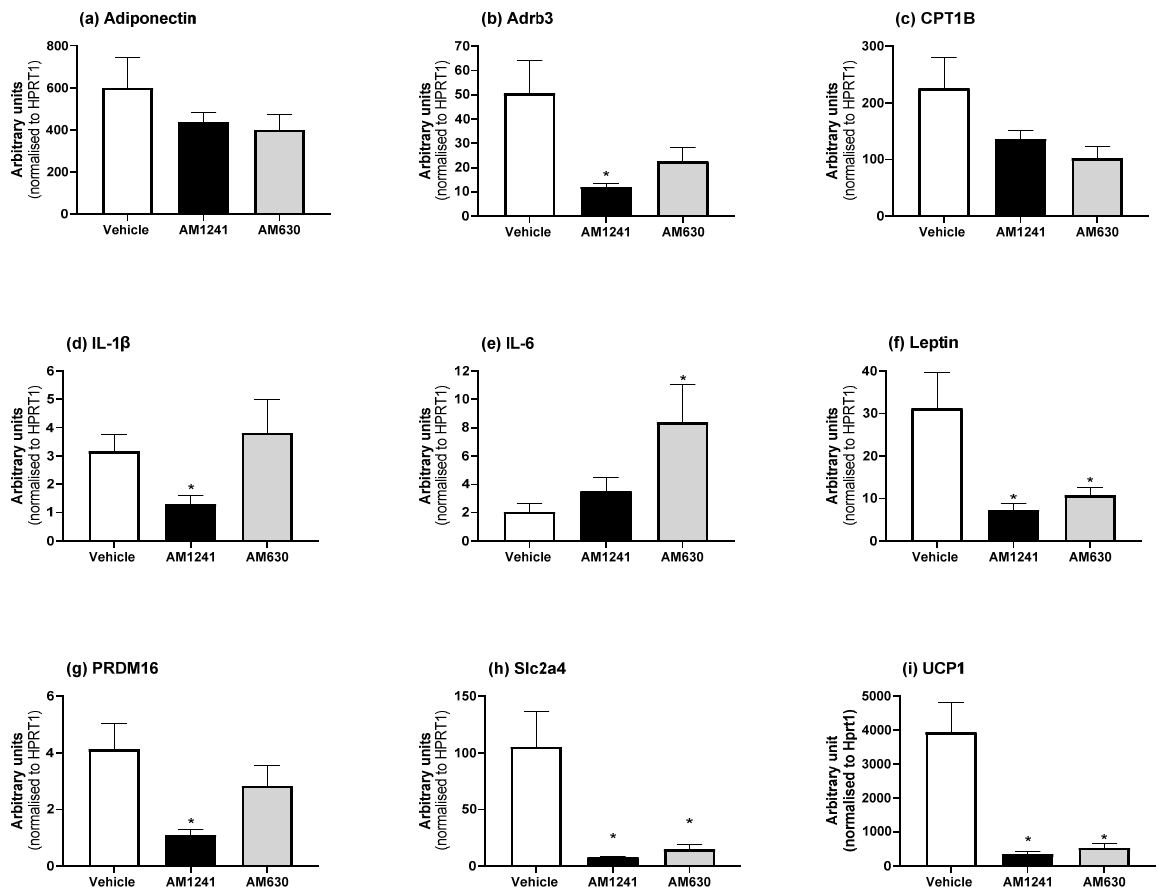
Figure 4. Effect of AM1241 or AM630 treatment in DIO rats on BAT mRNA expression. DIO rats were injected daily with either AM1241 (3 mg/kg of body weight, ip), AM630 (0.3 mg/kg of body weight, ip), or vehicle for six weeks. All results are presented as a mean ± SEM in arbitrary units (normalized to housekeeping gene HPRT1) from n = 7–9 (AM1241) ‐ , n = 7–9 (AM630) ‐ , and n = 7–9 (vehicle) ‐ treated rats on an HFD (exception n = 6 for IL ‐ 1 β for AM1241 and AM630). Significance * p < 0.05 compared to vehicle.